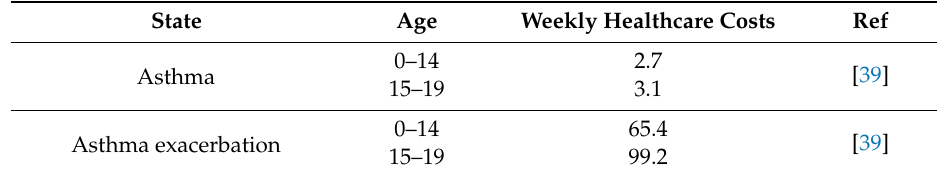
Table 4. Base-case and one-way sensitivity analysis results for Korean children who were exposed to SHS in the home compared with nonexposed children.